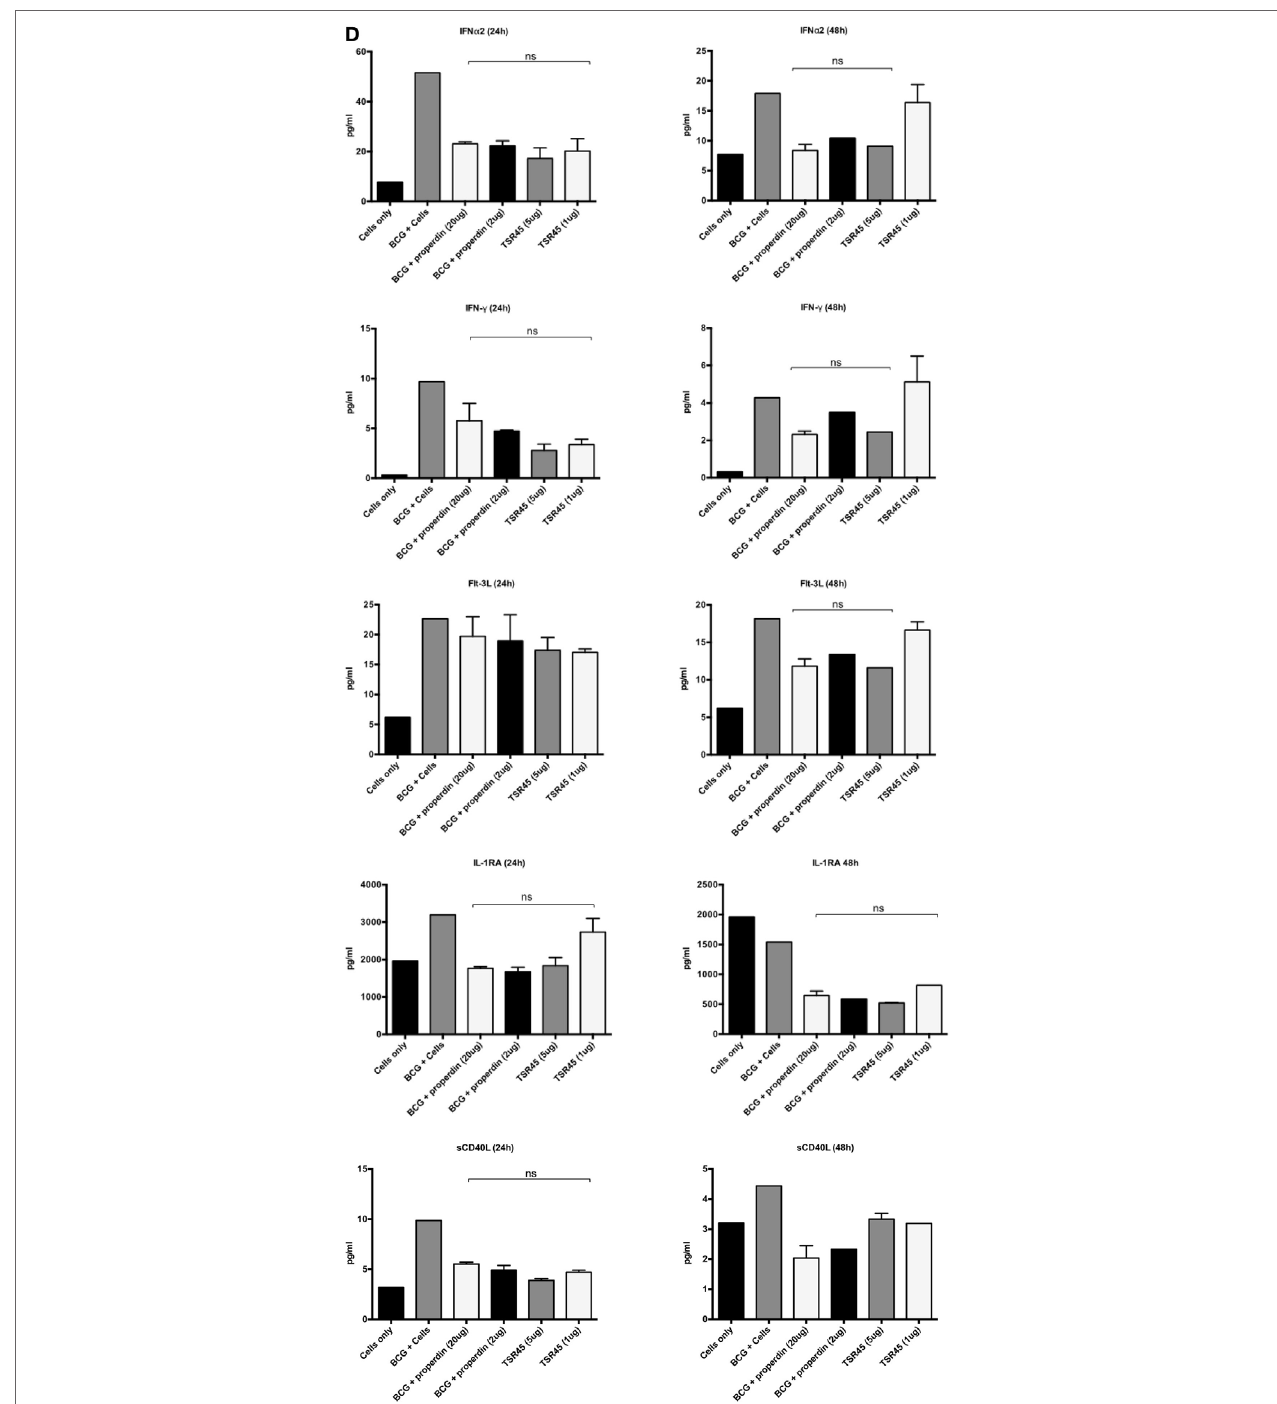
FigUre 6 | Multiplex cytokine analysis of supernatants collected at 24 and 48 h phagocytosis of Mycobacterium bovis BCG by THP-1 cells incubated with or without properdin and thrombospondin repeats (TSR) 4 + 5. The supernatants were collected from phagocytosis assay of M. bovis BCG in the presence or absence of properdin and TSR4 + 5 at 24 and 48 h time point. The levels of cytokine production were measured for (a) (IL-6, IL-10, IL-12p40, IL-12p70, IL-1 α , IL-1 β , TNF- α , IL-13, IL-15, IL-17A, IL-9, and TNF- β ), (B) chemokines (MCP-3, MDC, Eotaxin, Fractalkine, GRO, IL-8, IP-10, MCP-1, and MIP-1 α ), (c) growth factors (IL-9, IL-2, EGF, FGF-2, G-CSF, GM-CSF, IL-3, IL-4, IL-5, IL-7, and VEGF), and (D) related ligands and receptors (IFN- α 2, IFN- γ , FLT-3L, IL-1RA, and sCD40L) using multiplex analysis. Error bars represent SD. A one-way ANOVA test was performed on the data to determine significant differences in expression of cytokine production by properdin or TSR4 + 5. All comparisons were significant ( p < 0.05), unless where shown (ns, not significant, p > 0.05). Supernatants were analyzed in duplicate.